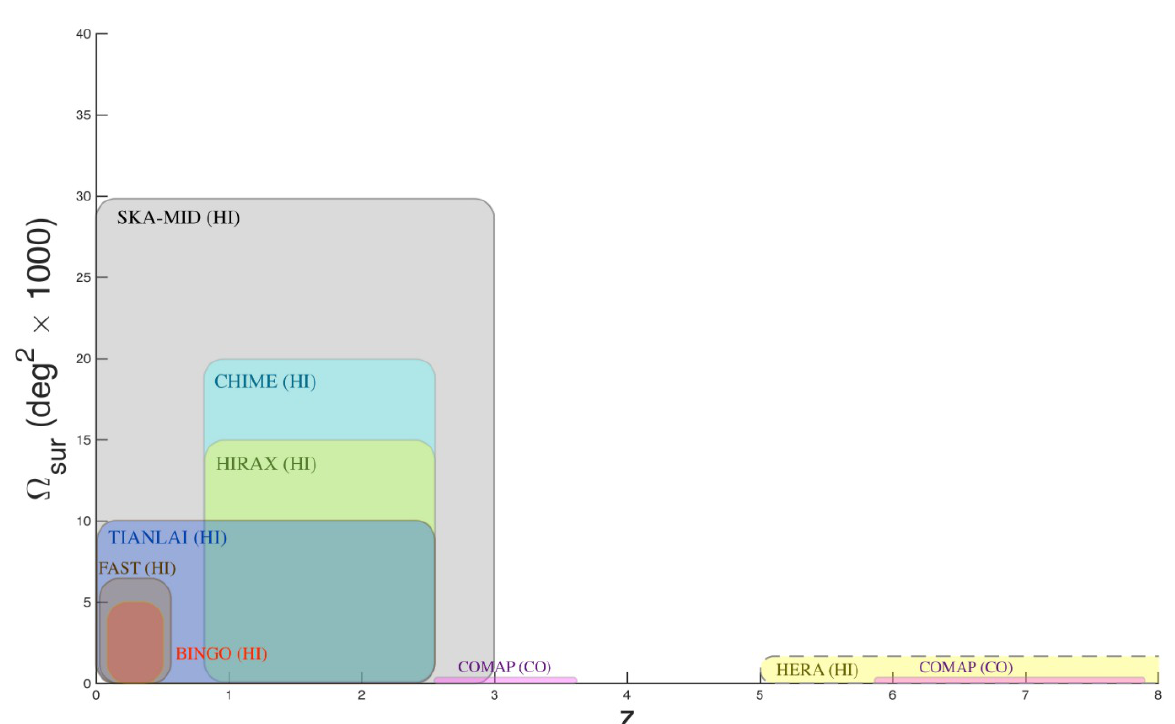
Figure 3. Comparative plot of sky and redshift coverage for different IM experiments. CHIME and FAST are in